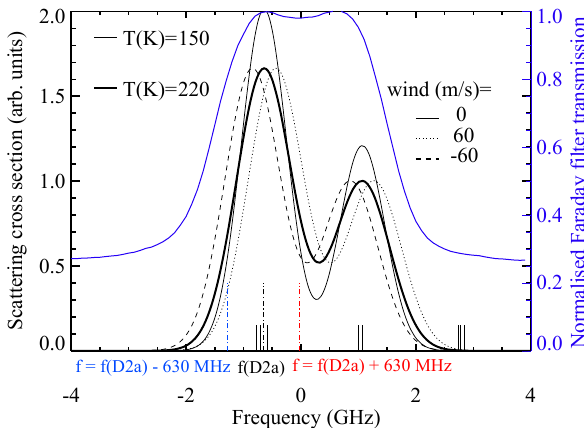
Fig. 1. The different black curves show the total backscattering cross section of the D 2 resonance transition in the Na hyperfine structure for different atmospheric temperatures and winds. The transmission curve of the FADOF is plotted in blue. The three emit- ted frequencies are marked by the three dashed-dotted lines. The eight black vertical lines mark the received fluorescence frequen- cies for the Na D 2